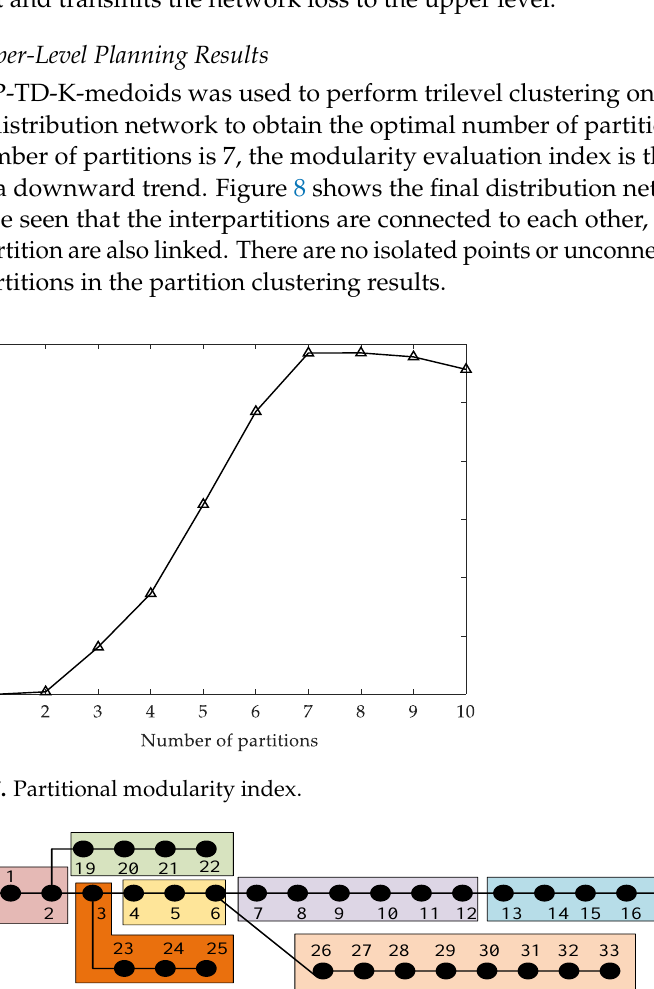
Figure 8. IEEE 33-bus distribution network partition results.